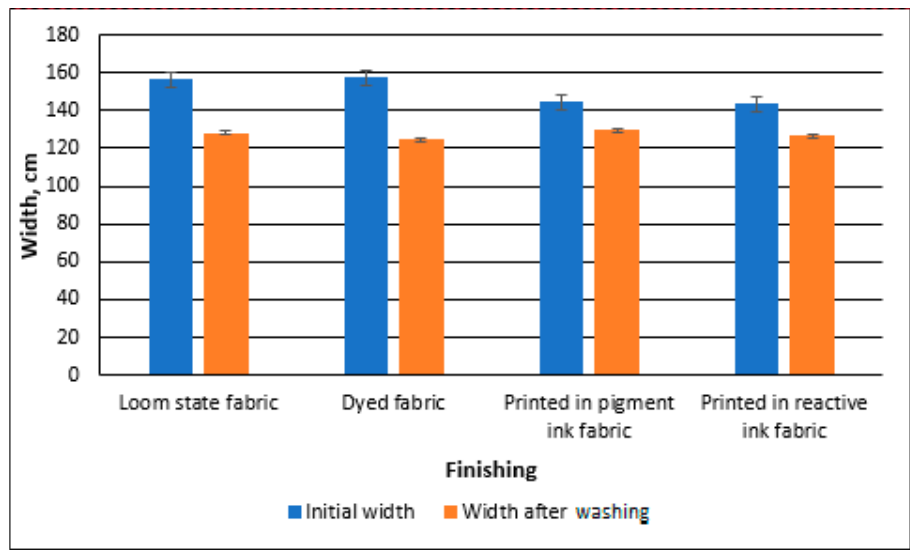
ing the values before and after washing different types of finishing. The changes in the width of raw and dyed fabrics were more prominent. After finishing, loom ‐ state and dyed fabrics shrank about 22%, whereas for both methods of printing, the fabrics shrank about 13%. Due to the more prominent shrinkage of the weft, loom ‐ state and dyed fabrics also produced higher shrinkage values. The shrinkage in the directions of weft is the reason for reducing the fabric’s width. The width of dyed fabric is higher than that of printed fabrics, because the printed fabrics are flatter and their shrinkage in the direction of weft is lower. References [20,25,26] analyzed fabric shrinkage in terms of fabric width and es ‐ tablished the same tendencies. Different auxiliaries (mordants, brighteners, and softeners) also improved fabric shrinkage, as mentioned in references [22,24,27].